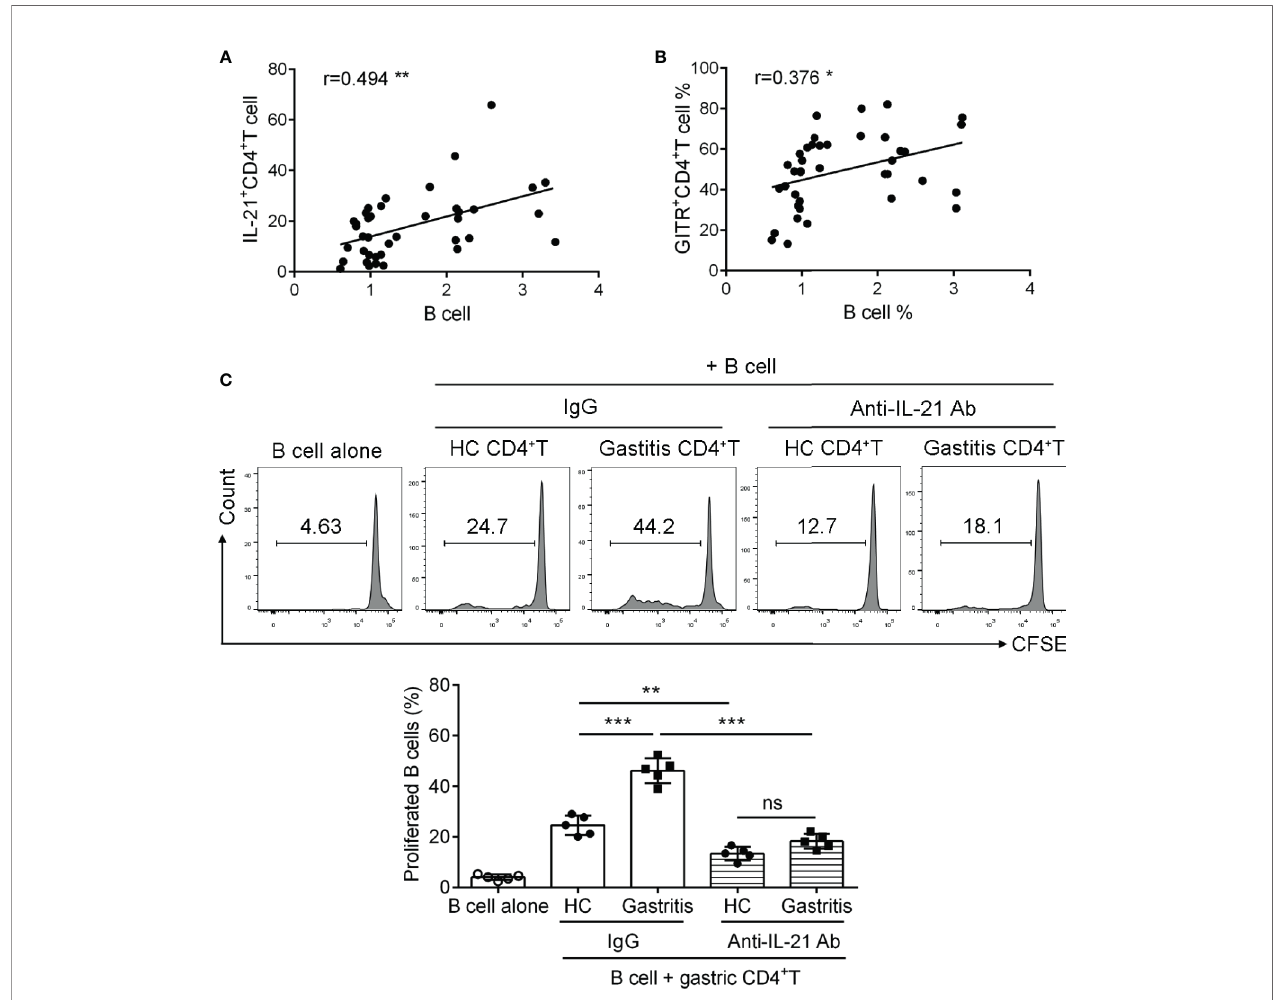
FIGURE 5 | IL-21 + TFH-like cells induced B cell proliferation in Helicobacter pylori -positive gastritis. (A, B) The correlations of B cell proportion with (A) IL-21 and (B) glucocorticoid-induced tumor necrosis factor receptor expression in mucosal CD4 + T cells of H. pylori -positive gastritis patients were analyzed by Spearman correlation analysis ( n = 39). (C) The gastric CD4 + T cells were respectively isolated from the gastric mucosa of H. pylori -positive patients and healthy controls and treated with CD3 Ab or recombinant GITRL protein for 12 h. Then, the gastric CD4 + T cells were co-cultured with carboxy fl uorescein succinimidyl ester-labeled autologous CD19 + B cells in the presence of IgG or anti-IL-21-neutralizing Ab. At 3 days later, the percentage of proliferated B cells was assessed by fl ow cytometry. One-way ANOVA was used to compare among three or multiple groups. Data are shown as mean ± SD from at least three independent experiments. ns, P > 0.05; * P < 0.05; ** P < 0.01; *** P <